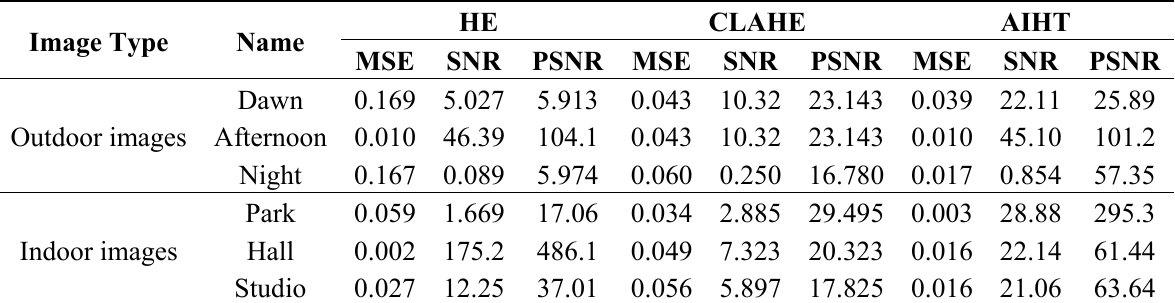
Table 3. Compared results of HE, CLAHE and AIHT methods using Mean Square Error